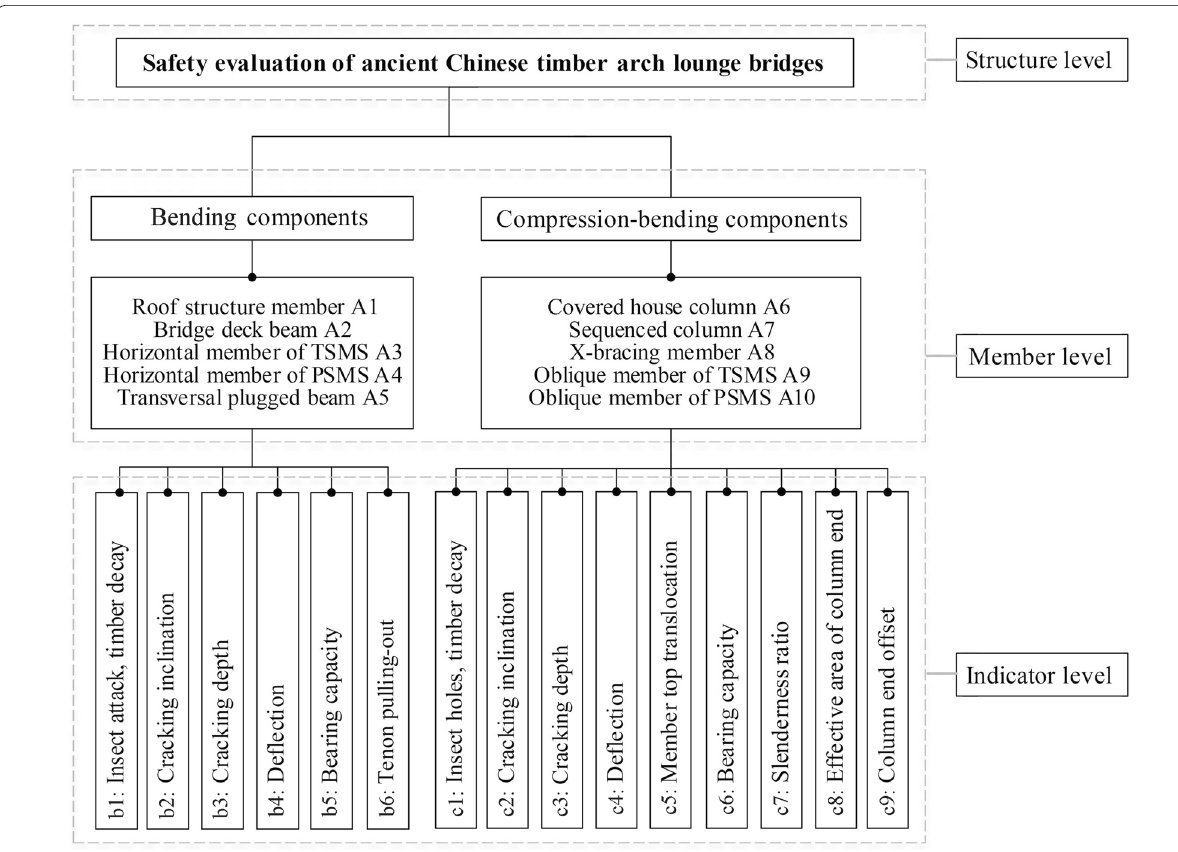
Table 1 Assessing indicators and grading criteria for bending